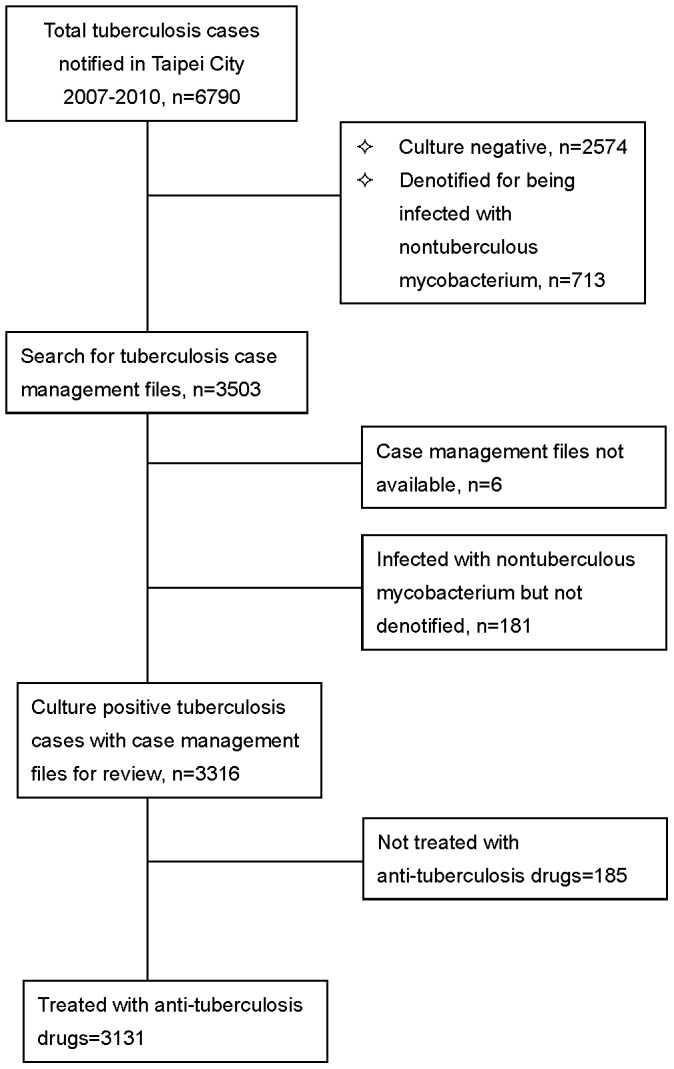
Flow chart of study population.